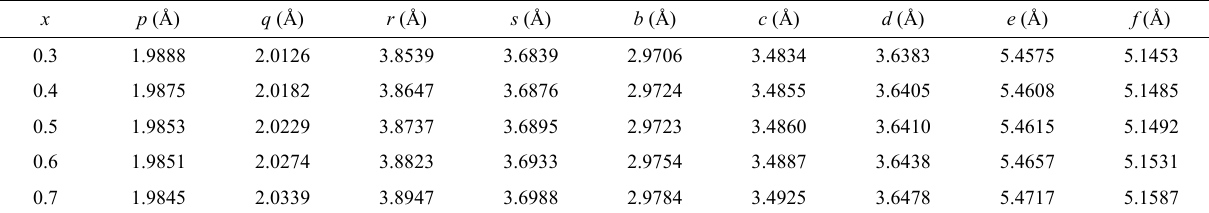
Fig. 2 Distance and angles between cation–cation and cation–anion at A and B sites. Table 4 Cation–anion distances ( p , q , r , s ) and cation–cation distances ( b , c , d , e , f ) for Mg 1– x Zn x Fe 2 O 4 ( x = 0.3, 0.4, 0.5, 0.6, and 0.7)